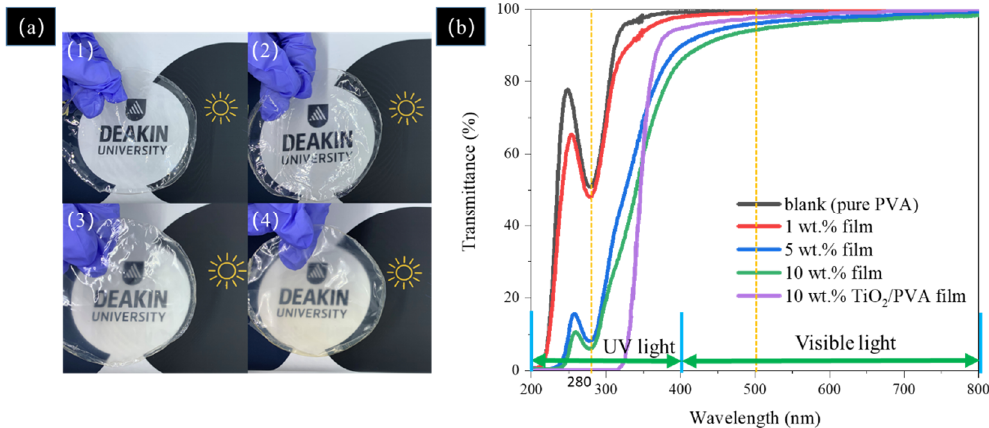
Figure 8. ( a ) Photographs of the film: (1) pure PVA, (2) 1 wt. % film, (3) 5 wt. % film, (4)10 wt. % film; ( b ) Transmission spectra of the composite films with various hemp hurd additions in this study and TiO 2 / PVA film reproduced from Liu et al. [42].